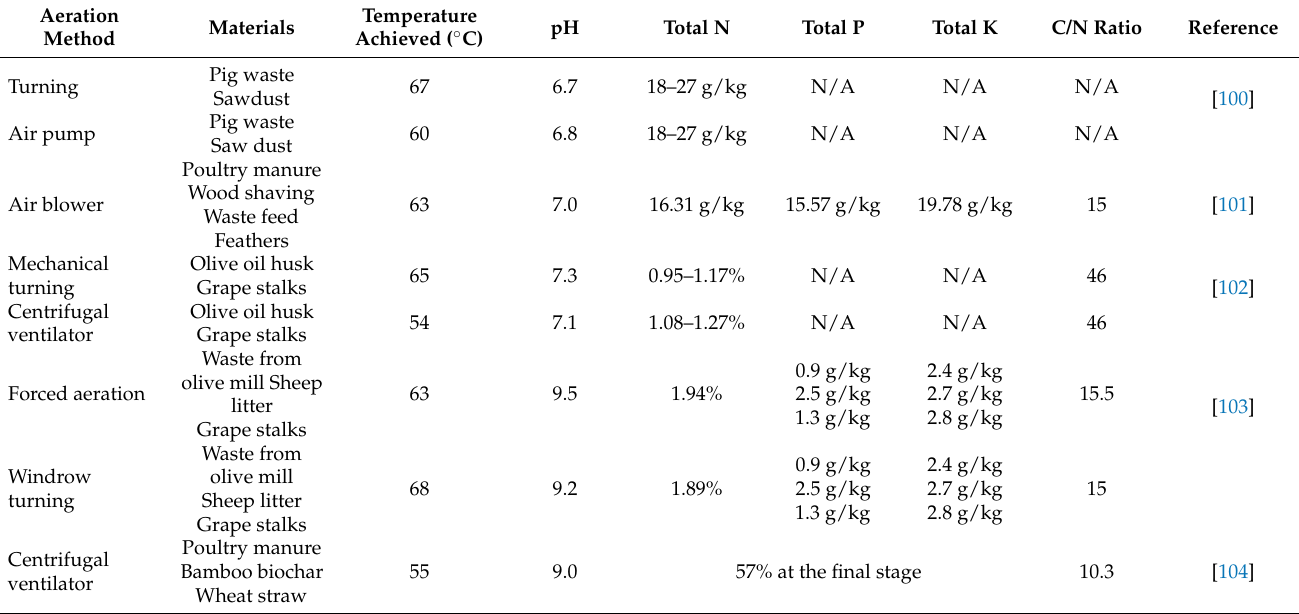
Table 5. Chemical properties of different materials in various aeration methods.